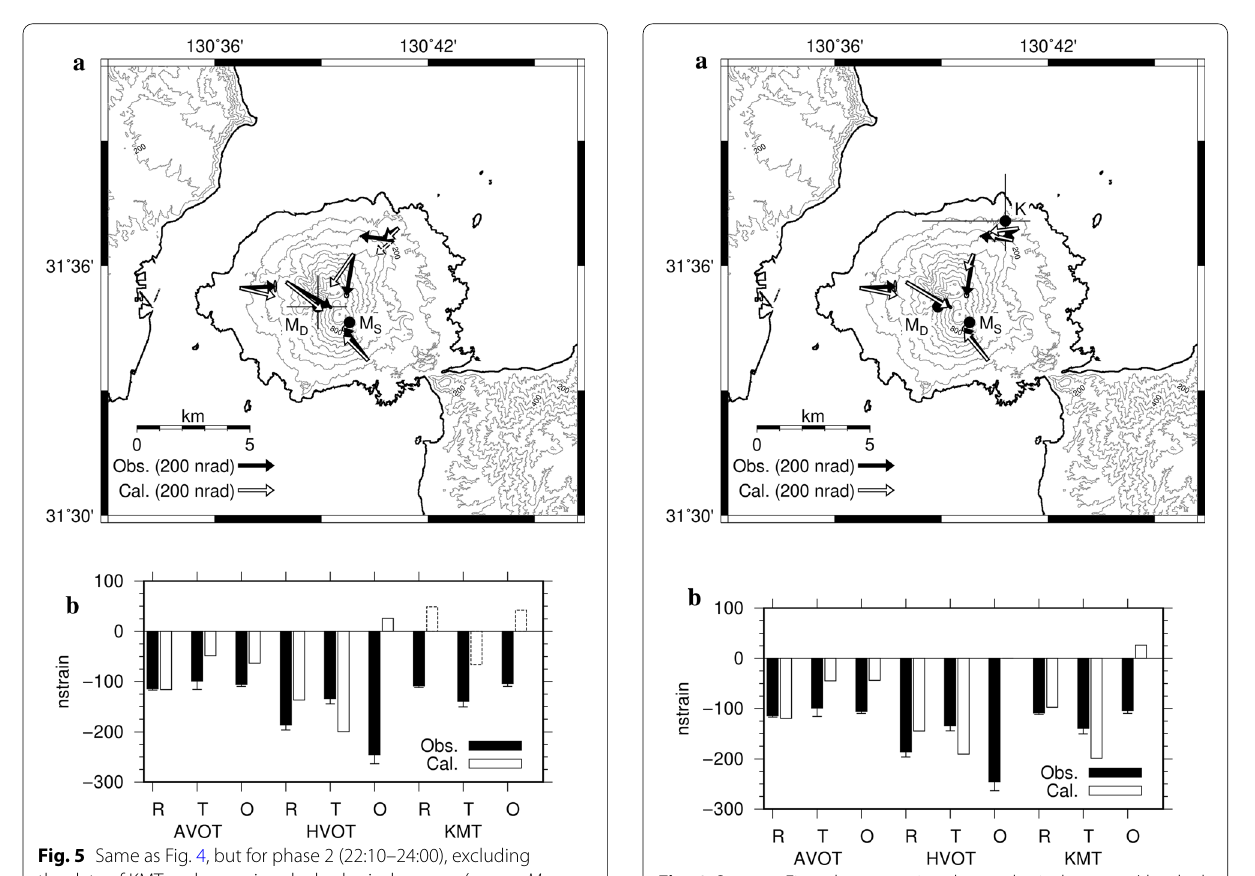
Fig. 6 Same as Fig. 4, but assuming three spherical sources (the dual Minami-dake sources M S and M D and an additional spherical source K ) for all the data including KMT. The depths of the sources M S , M D and K were 0.1 km bsl, 3.3 km bsl and 3.2 km bsl,